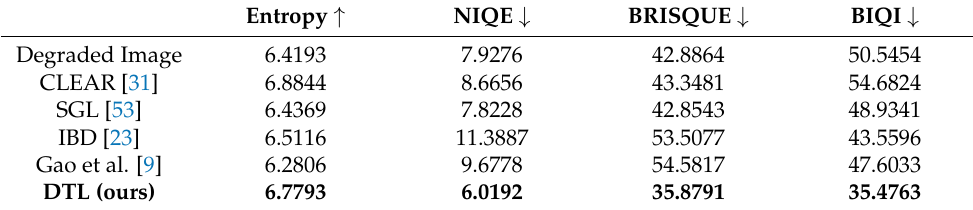
Table 4. Objective assessment of the above restoration methods. Entropy ↑ NIQE ↓ BRISQUE ↓ BIQI ↓ Degraded